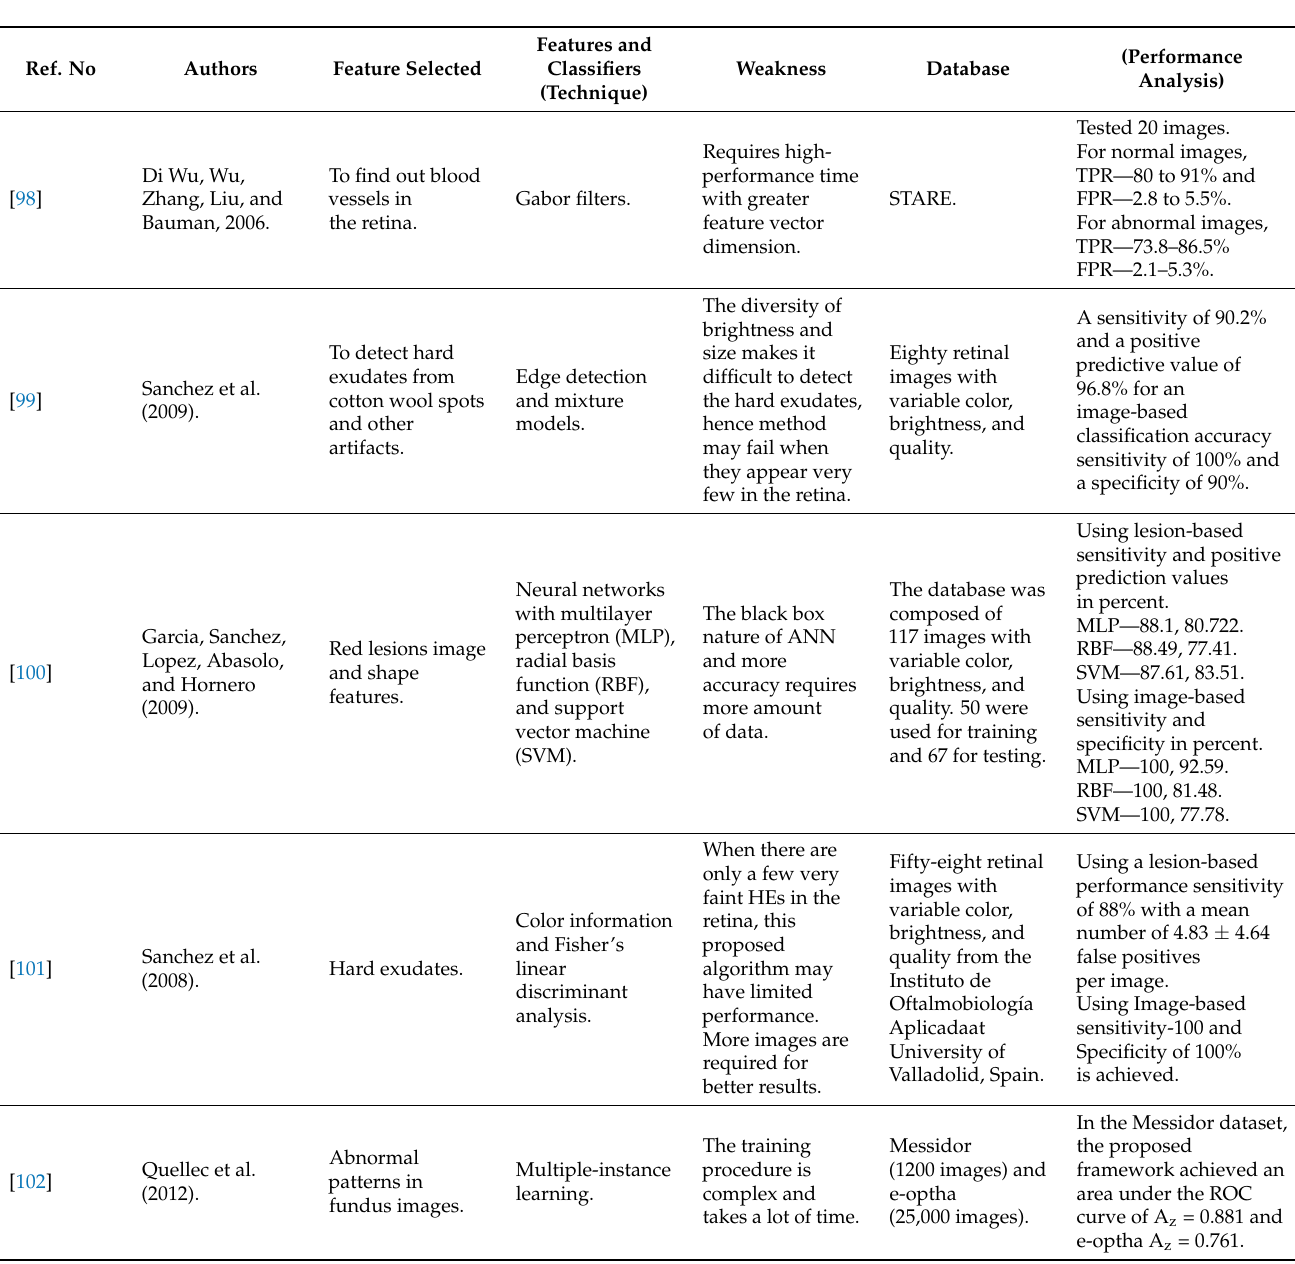
Table 7. Traditional feature extraction methods used in